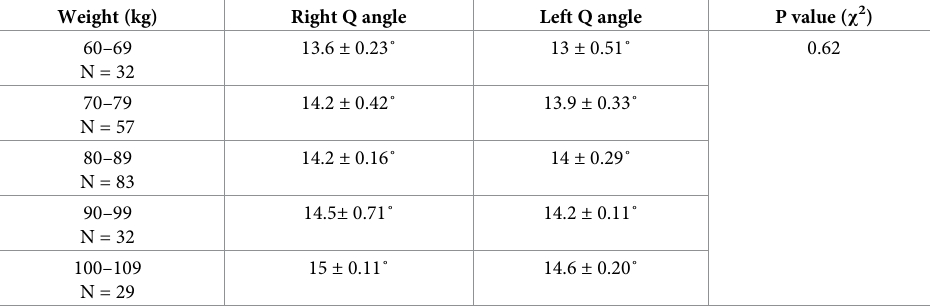
Table 1. Measurements of the Q angle with respect to weight in the adult men.